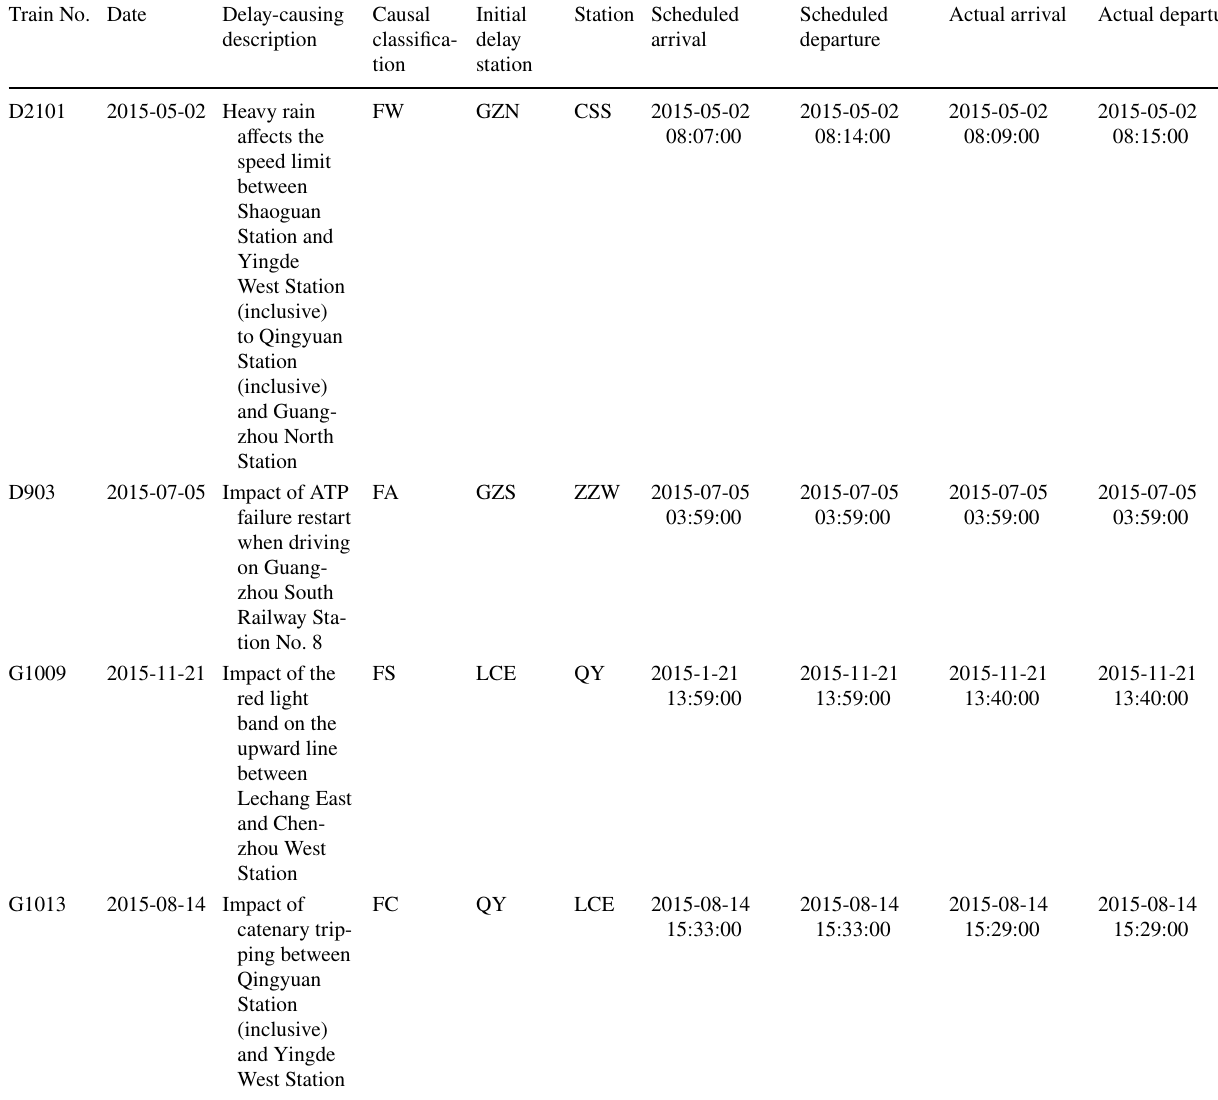
Table 1 Raw data example